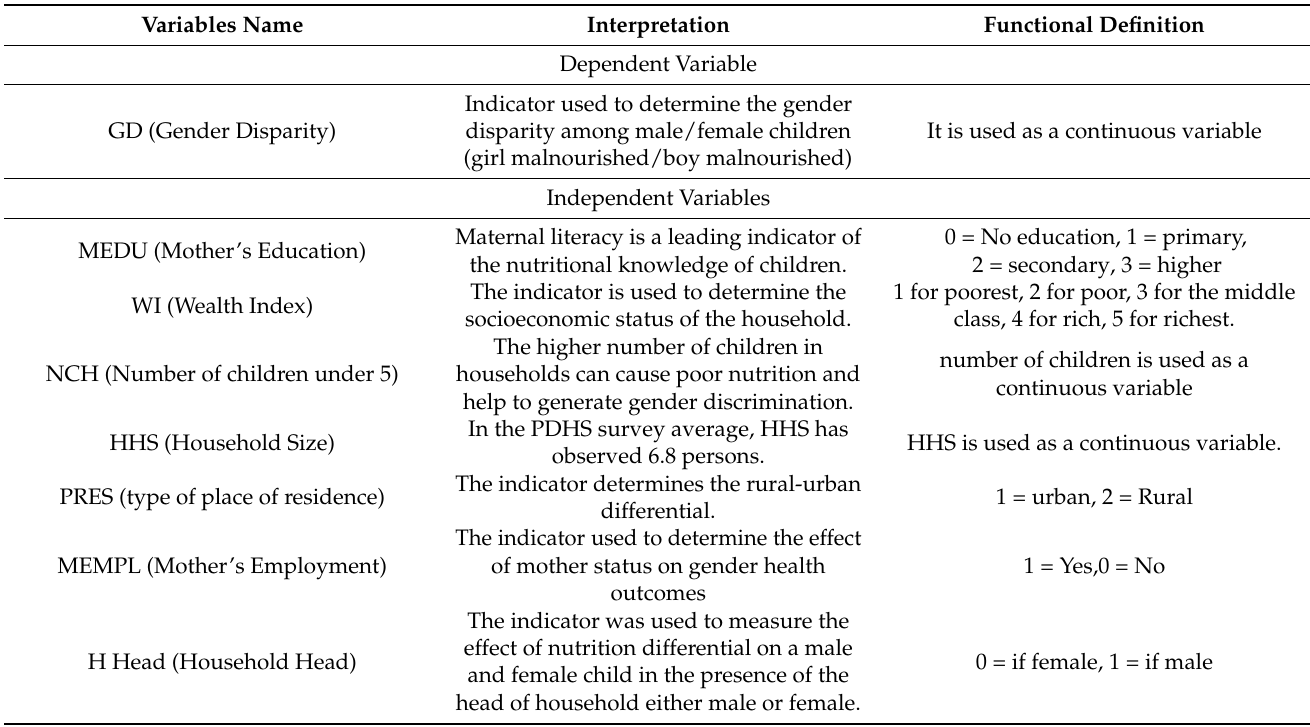
Table 1. Functional Features of